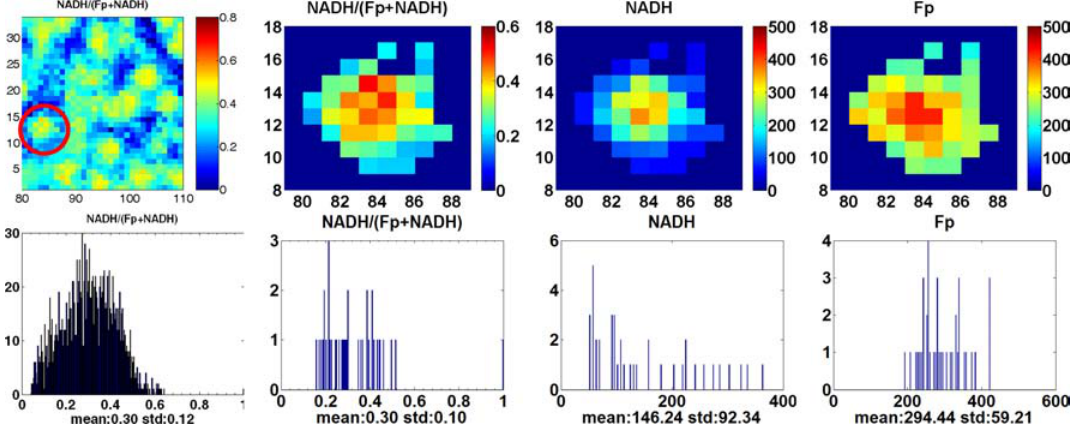
Fig. 9. The typical images of mouse embryonic stem cell colonies and their corresponding histograms. The images show that the undi®erentiated cells (in the central region) are more reduced. The right three images and the corresponding histograms correspond to the individual ESC colony in the red circle of the ¯rst redox